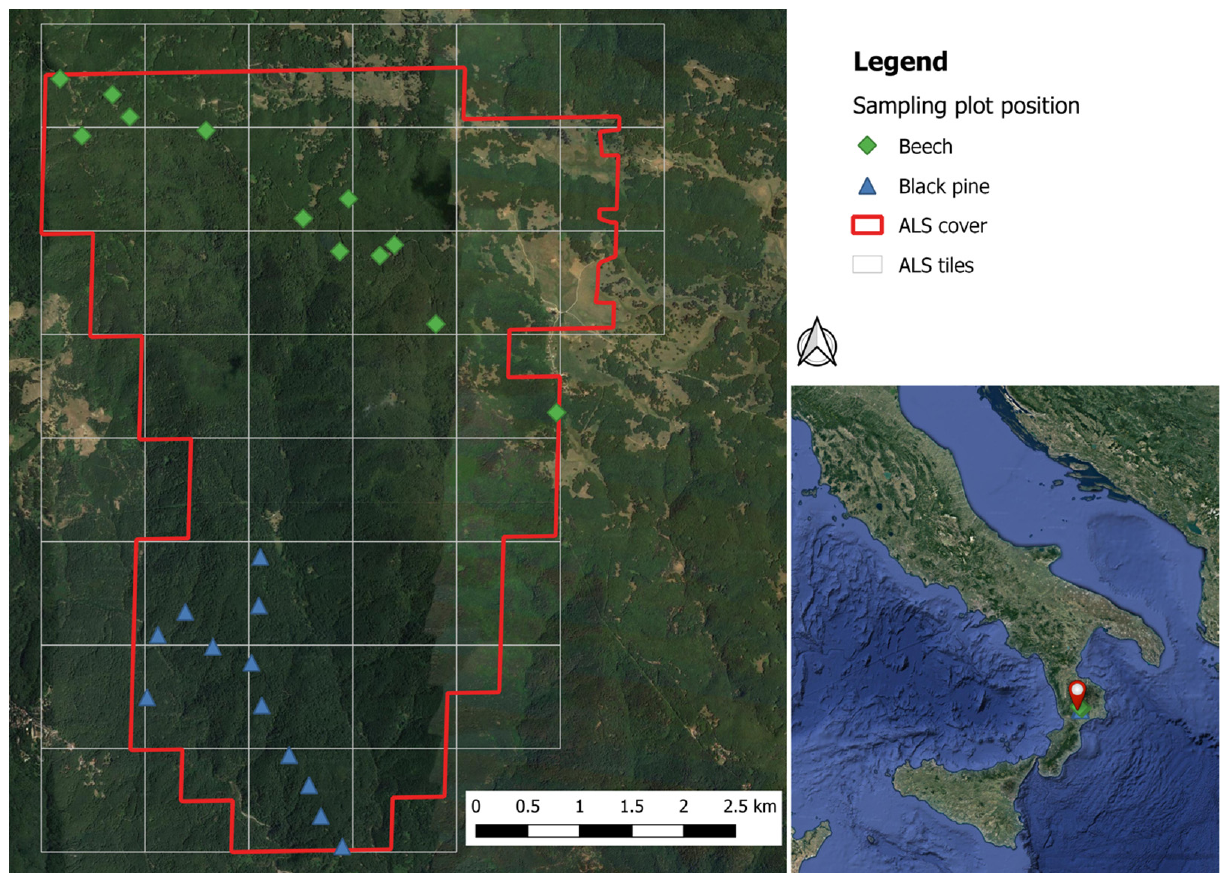
Figure 1. Plot locations and ALS tiles of the study area.